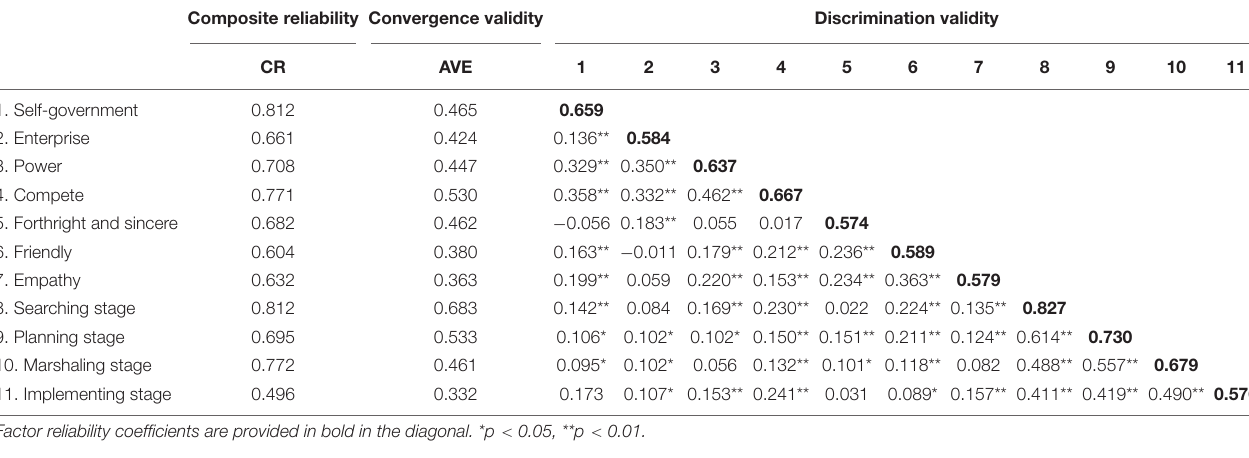
TABLE 4 | Correlations.